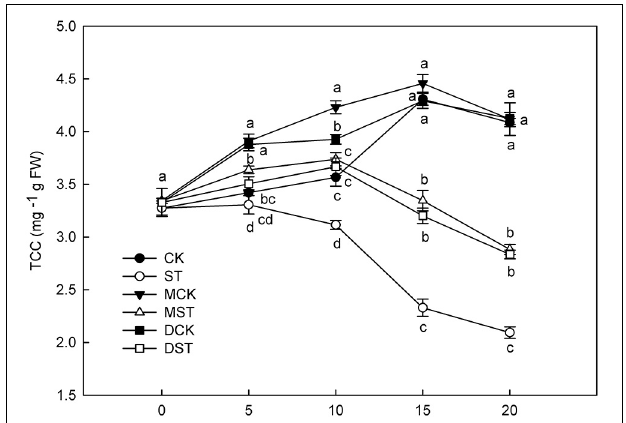
FIGURE 1 | Effect of melatonin and dopamine on total chlorophyll concentration (TCC) under different N levels and material treatments. Data are means ± SD of five replicate samples. Values not followed by same letter denote significant differences by Tukey’s multiple range tests ( P < 0.05). CK, 2 mM K 15 NO 3 solution; ST, 0.1 mM K 15 NO 3 solution; MCK, 2 mM K 15 NO 3 solution with 0.1 µ mol/L melatonin; MST, 0.1 mM/L K 15 NO 3 solution with 0.1 µ mol/L melatonin; DCK, 2 mM K 15 NO 3 solution with 100 µ mol/L dopamine; DST, 0.1 mM K 15 NO 3 solution with 100 µ mol/L